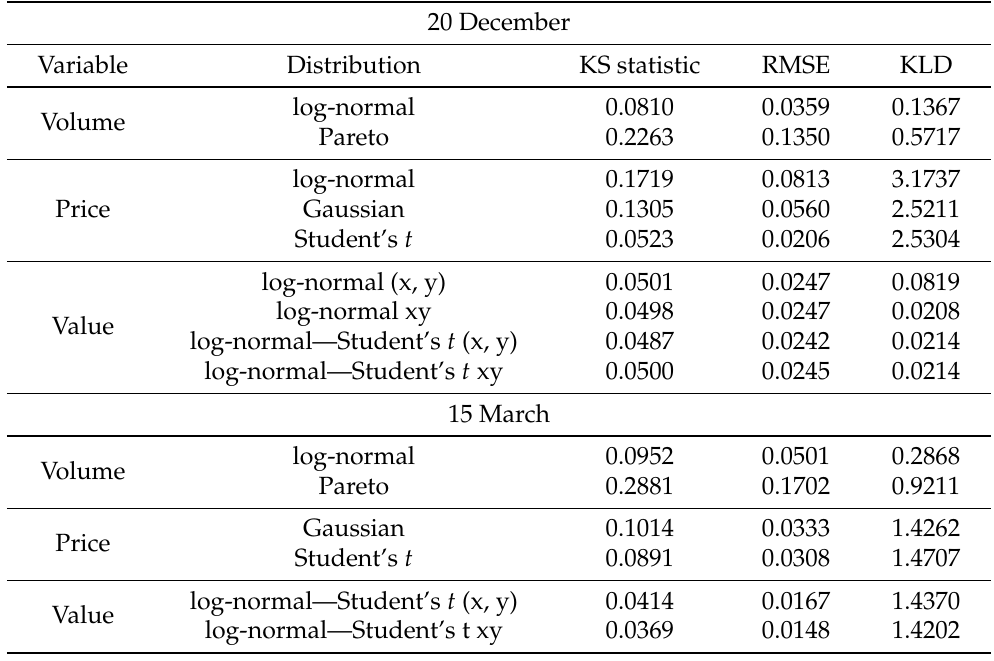
Table 1. Values of the Kolmogorov–Smirnov (KS) statistics, root mean square error (RMSE) and Kullback–Leibler divergence between the data and the considered distributions. KS statistic and RMSE were calculated as the means from 1000 simulated samples from the considered